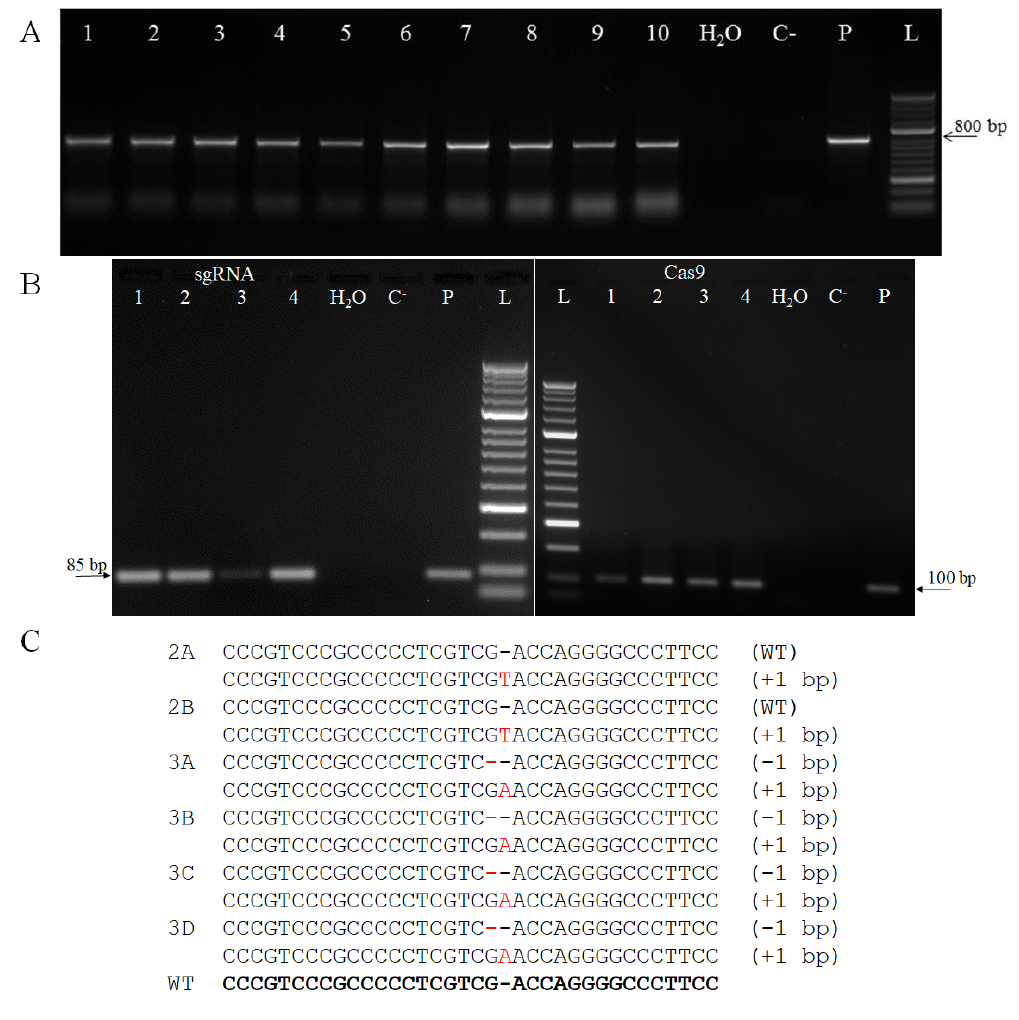
Figure 2. Characterization of primary regenerants at DNA and RNA level. ( A ) Detection of Cas9 transgene in samples of genomic DNA of T0 plants. L – DNA ladder (HyperLadder 50-bp, Bioline); P